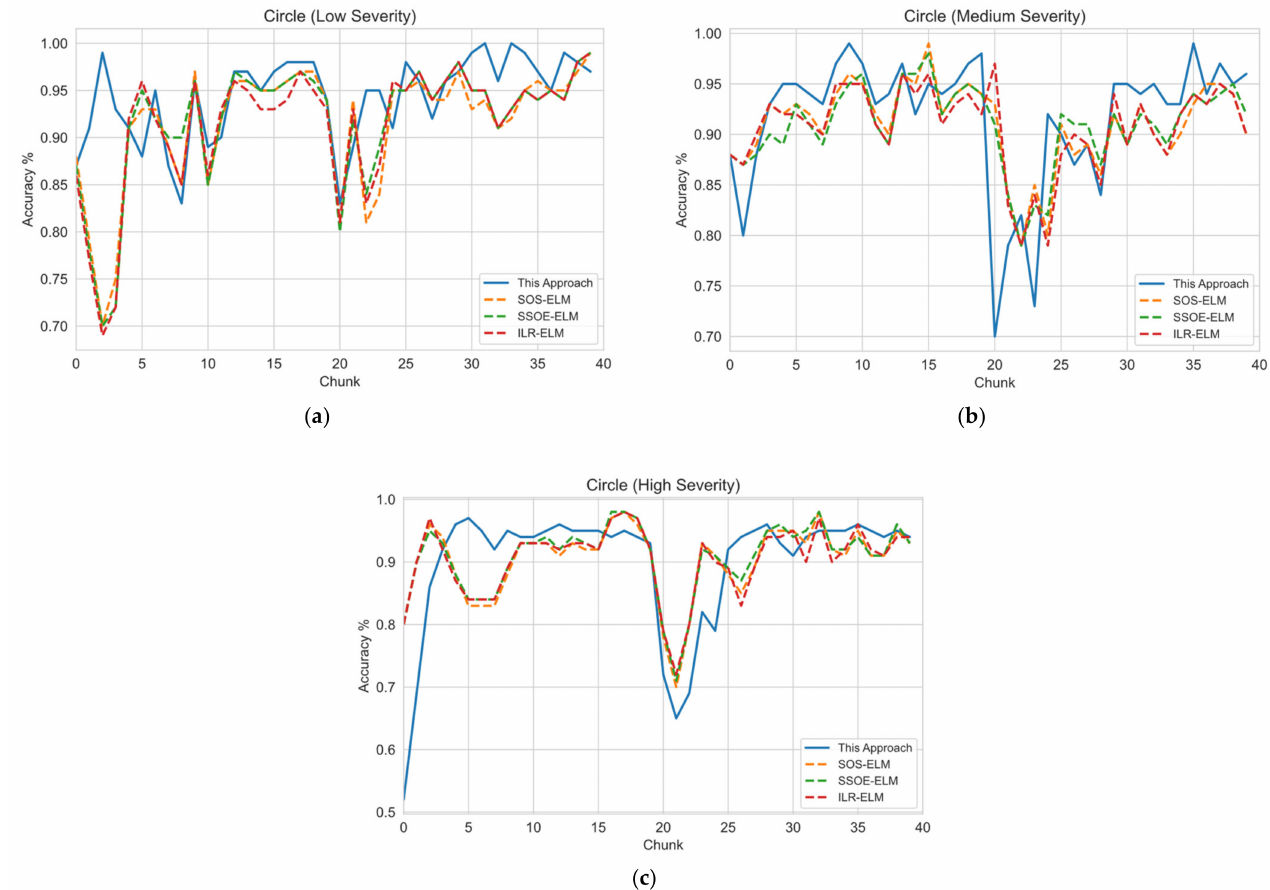
Figure 3. Circle dataset experiment on variable concept drift severity. ( a ) Performance on low severity dataset. ( b ) Performance on medium severity dataset. ( c ) Performance on high severity